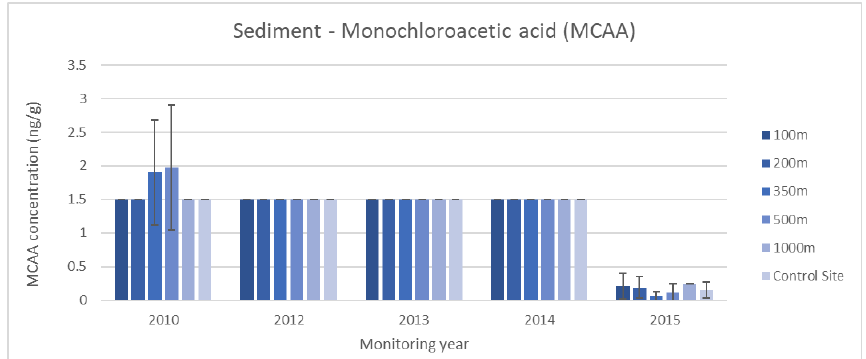
Figure 7. MCAA concentrations in sediment samples (means ± L-levels) collected from 2010 to 2015 at different sites located far (100 m; 200 m; 350 m; 500 m; 1000 m) from LNG terminal and at control site in the Northern Adriatic Sea. Table 2. Sediment concentration ratios (SCRs) for DBAA and MCAA resulted during monitoring activities of an LNG terminal in the Northern Adriatic Sea. (1) July, (2) September. Distance from the LNG Terminal DBPs